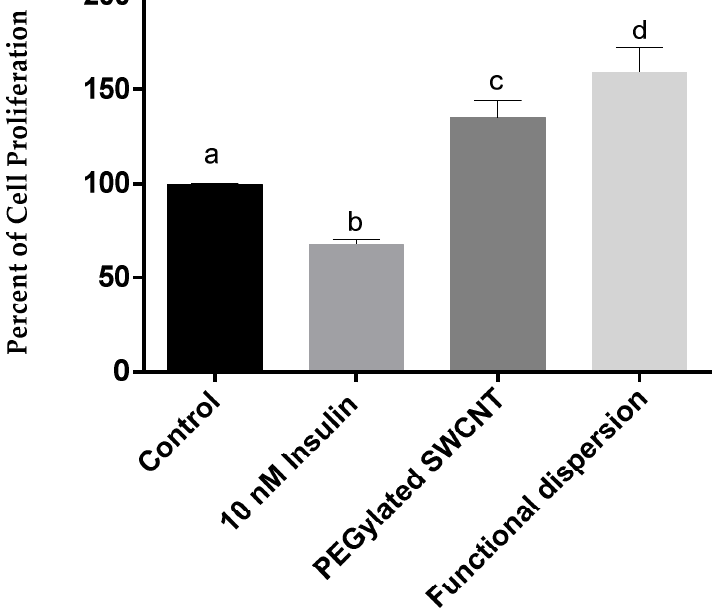
Figure 4. Percent of cell proliferation of rat L6 skeletal muscle cell lines treated with 10 nM insulin, 5 µg/mL PEGylated SWCNT, Functional dispersion (10 nM insulin and 5 µg/mL PEGylated SWCNT) for 24 h. Means with different letters are significantly different at p < 0.05 calculated using the two-tailed unpaired t -test. All data are represented as the mean ± S.D of triplicates.